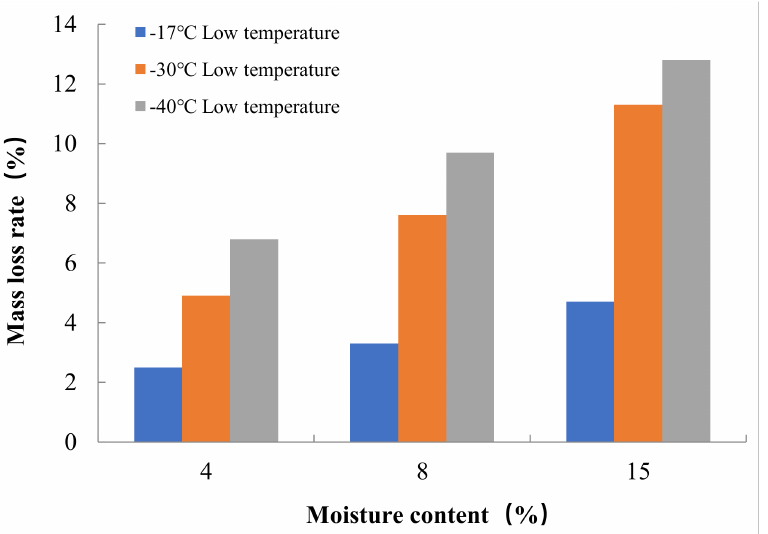
Figure 5. Relationship between internal moisture content and mass loss rate of concrete for freeze– thaw cycle